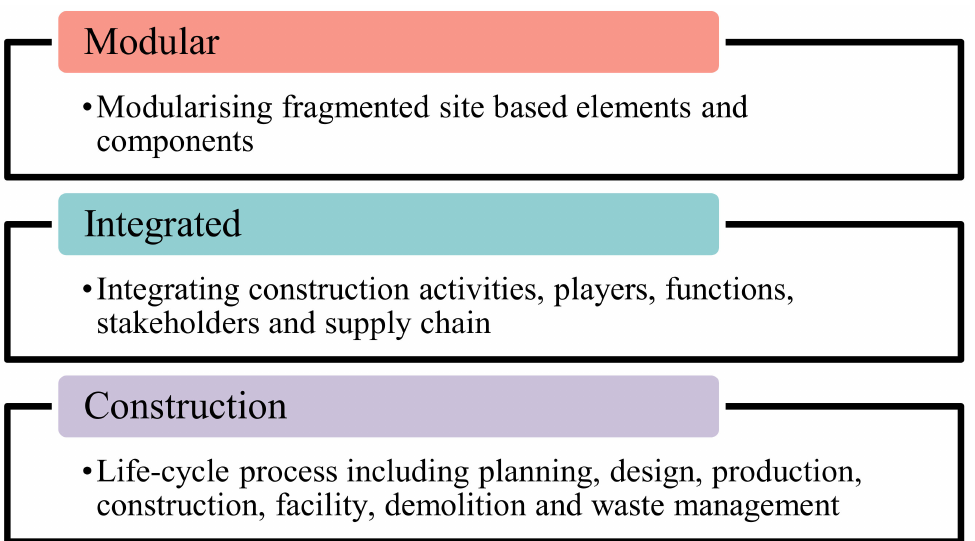
Figure 1. Breakdown of Modular Integrated